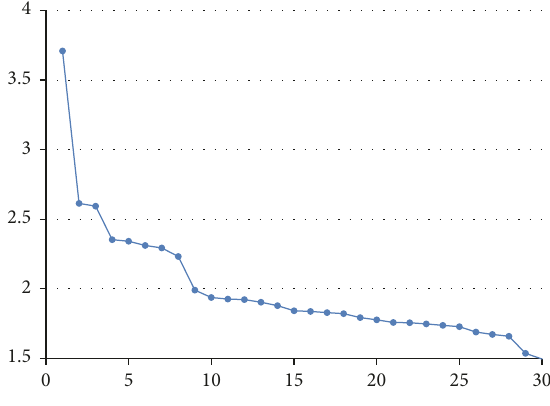
Figure 8: Logarithms of the 30